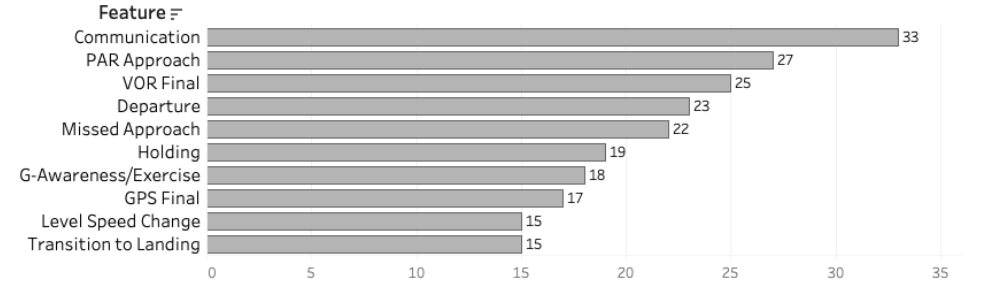
Figure 14. Top 10 features utilized to estimate attrition